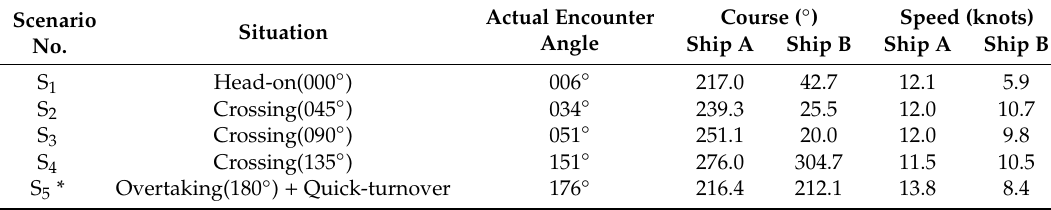
Table 4. Maneuvering data for small vessels.